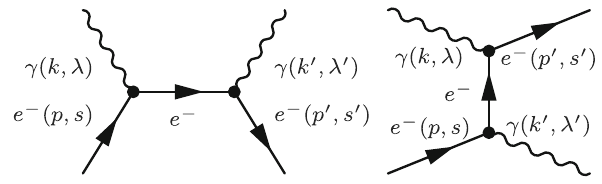
Fig. 3 Feynman diagrams for scattering of photon on electron